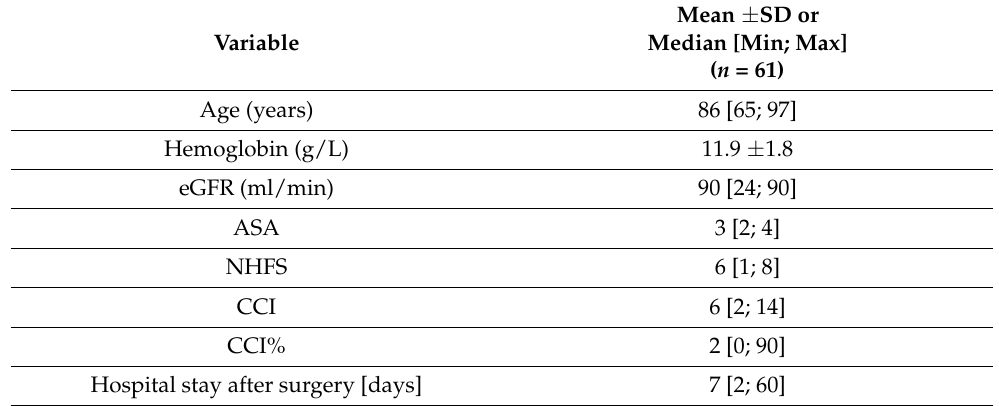
Table 1. Descriptive statistics.